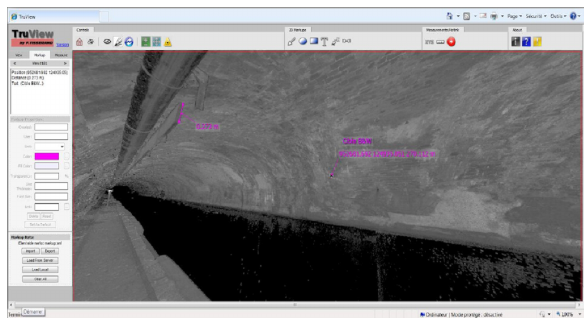
Figure 2: Rendering of the reference model of the tunnel.